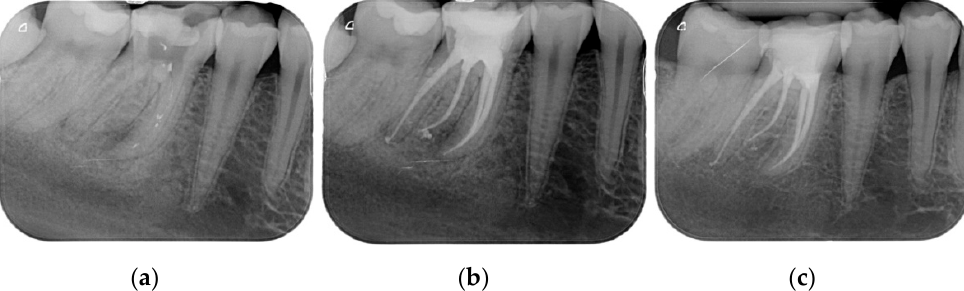
Figure 2. ( a ) A lower bicuspid in need to be endodontically treated because of necrosis of the pulp and periapical lesion; ( b ) The tooth after being endodontically treated. Two canals were found, cleaned and filled; ( c ) The tooth at 2 years recall. The periapical lesion completely disappeared.